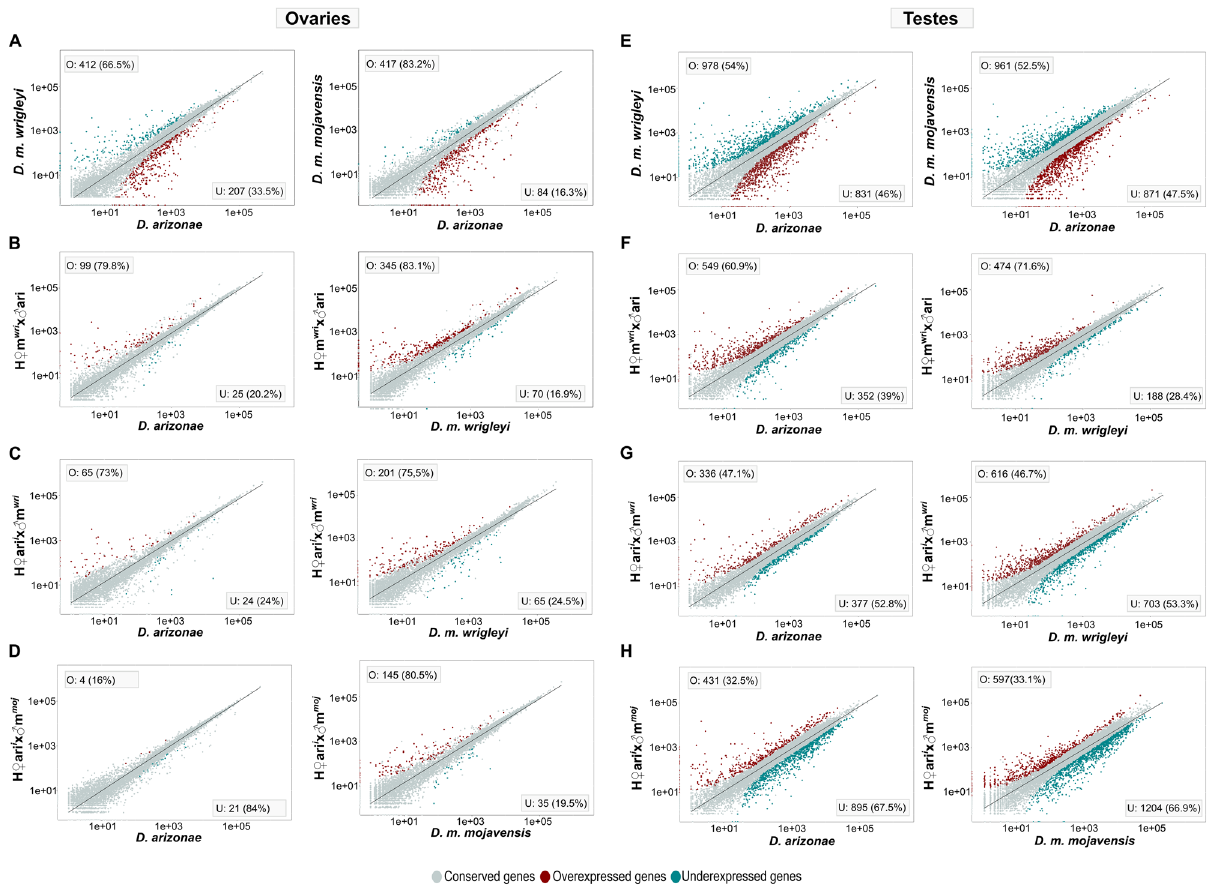
Figure 2. Differential gene expression between D. arizonae and D. mojavensis subspecies and between hybrids and their respective parental lines. Scatter plots representing differential gene expression in ovaries (left) and testes (right) between parental lines, as well as between hybrids and their respective parental lines. Genes were considered differentially expressed when they presented twofold differences and FDR-corrected p -values < 0.01. Red dots = overexpressed genes; blue dots = underexpressed genes; grey dots = not differentially expressed. ( A ) Differential expression in ovaries of D. m. mojavensis × D. arizonae and D. m. wrigleyi × D. arizonae hybrids. ( B ) Differential expression in ovaries of H ♀ m wri ♂ ari × D. m. wrigleyi hybrids and D. arizonae . ( C ) Differential expression in ovaries of H ♀ ari ♂ m wri × D. m. wrigleyi hybrids and D. arizonae . ( D ) Differential expression in ovaries of H ♀ ari ♂ m moj × D. m. mojavensis hybrids and D. arizonae . ( E ) Differential expression in testes of D. m. mojavensis × D. arizonae and D. m. wrigleyi × D. arizonae hybrids. ( F ) Differential expression in testes of H ♀ m wri ♂ ari × D. m. wrigley i hybrids and D. arizonae . ( G ) Differential expression in testes of H ♀ ari ♂ m wri × D. m. wrigleyi hybrids and D. arizonae . ( H ) Differential expression in testes of H ♀ ari ♂ m moj × D. m. mojavensis hybrids and D. arizonae . The scatter plot was generated using the ggplot2 package (version 3.3.3) in R 79 . O: overexpressed genes; U: underexpressed